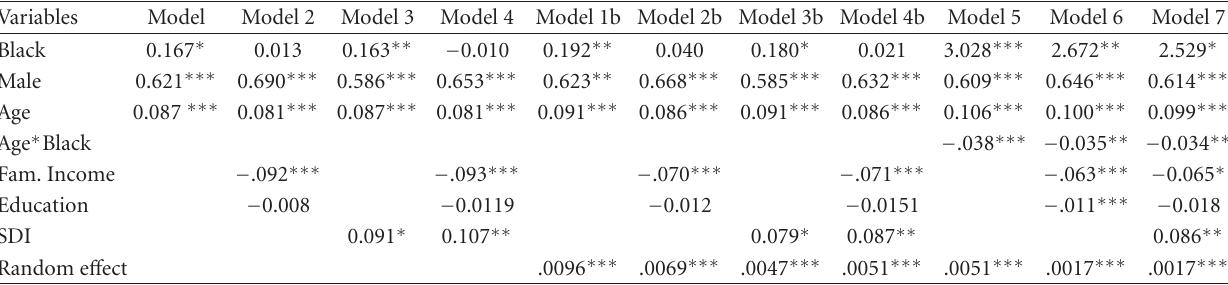
Table 2: The e ff ect of individual SES, neighborhood context on mortality over time (1986–2002) for people aged 65+ at baseline: multilevel survival model.